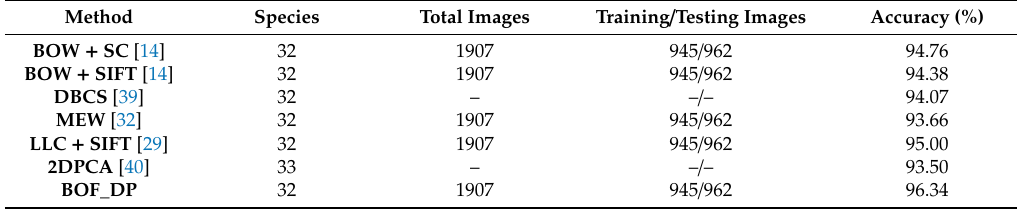
Table 1. Comparison of proposed feature with existing features on Flavia dataset.